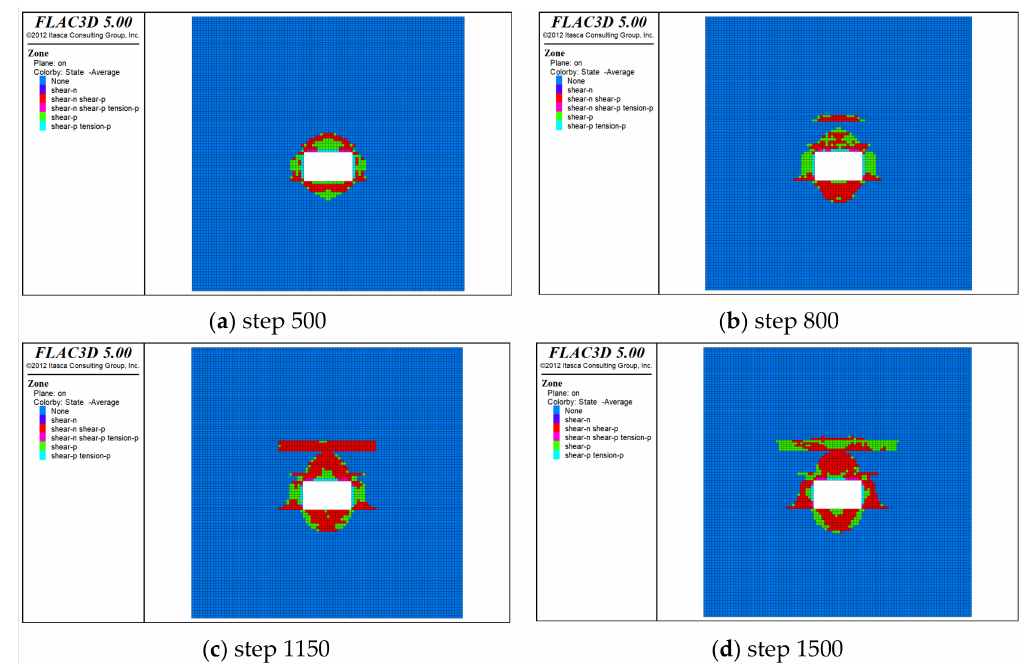
Figure 13. Plastic zone failure process of roadway surrounding